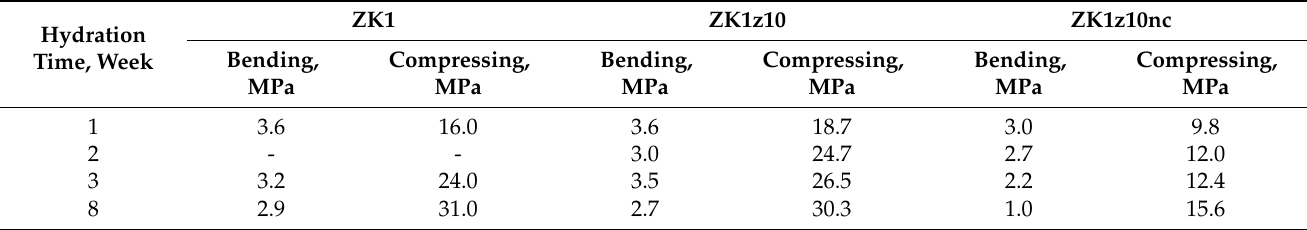
Table 7. Strength of binders after 1, 2, 3 and 8 weeks of hydration in dry conditions.